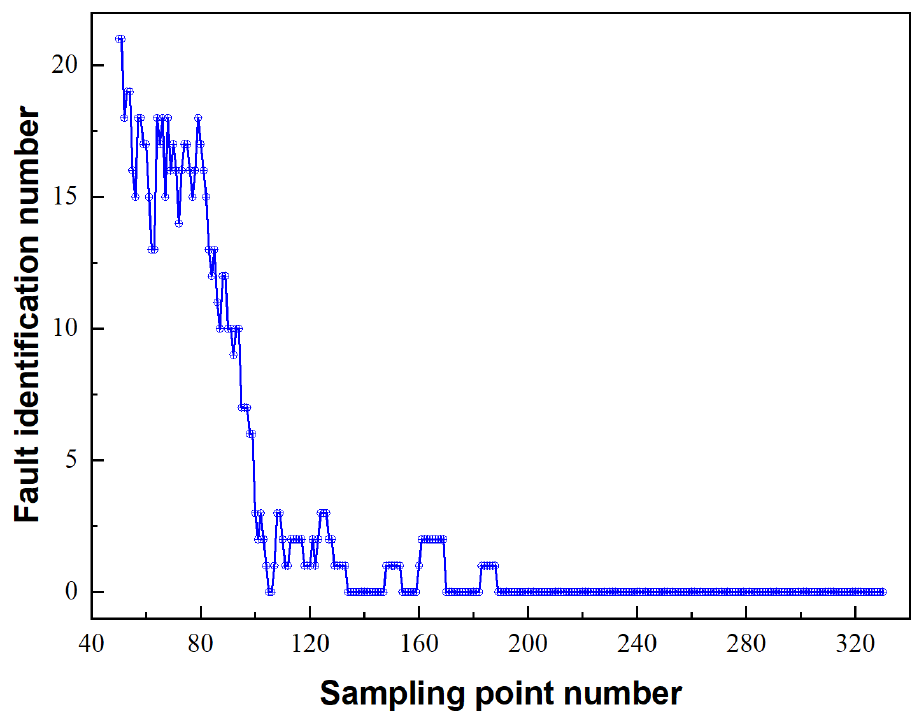
Figure 5. FIN versus SPNs for region localisation through cosine similarity.